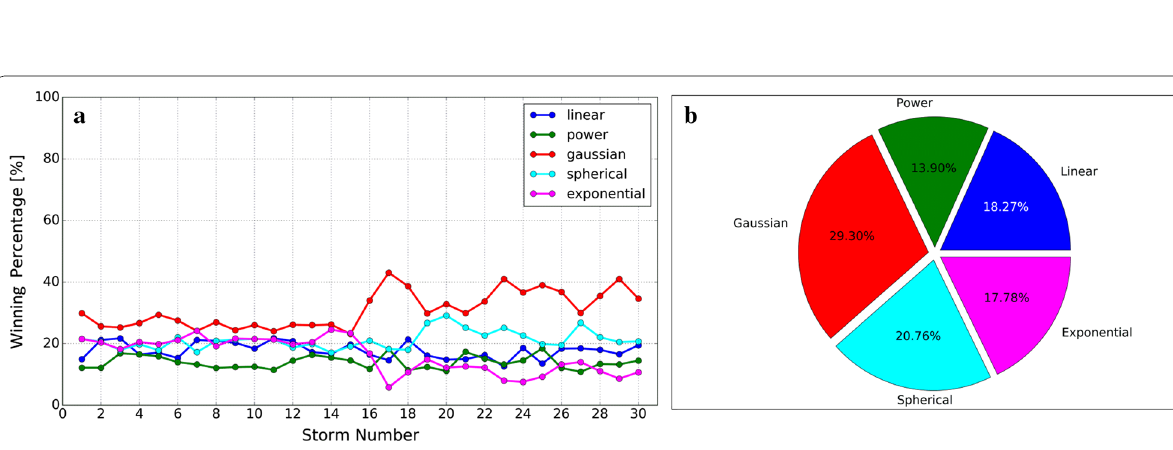
Fig. 13 Percentage of IG 12eff variogram models declared winners by the NQCR procedure. a Winning percentages related to each IG 12eff variogram model, for each single storm, after applying the NQCR procedure sketched in Fig. 6; b same as a but considering all storms listed in Table 3 as a whole